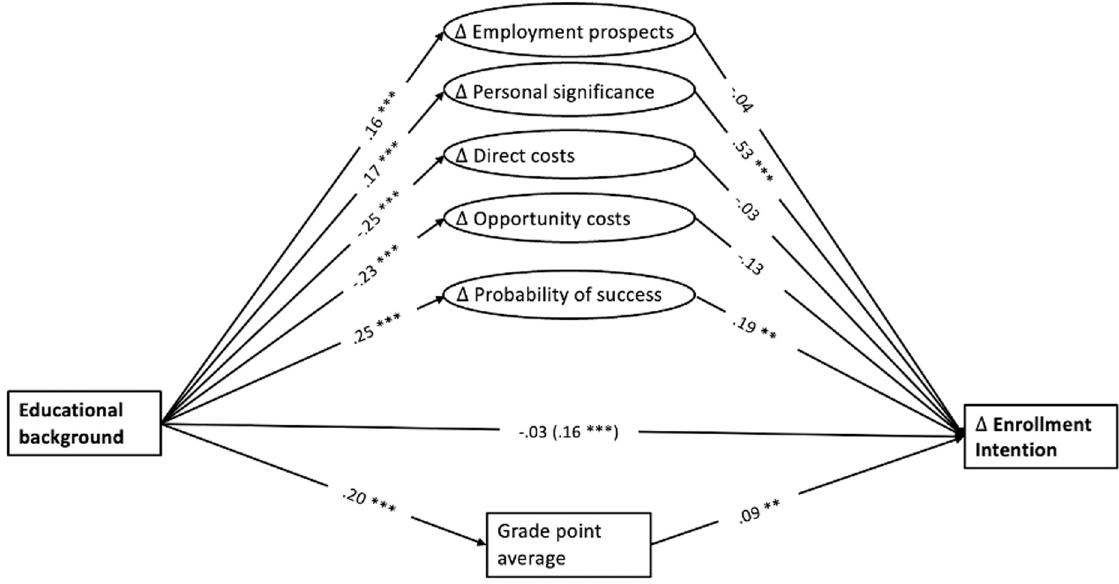
Fig 1. Standardized coefficients of the mediation model of educational background on intention to enter HE through rational choice patterns and academic performance. Standardized linear regression coefficients are presented. The total effect is presented in brackets. Educational background: 0 = non-academic household; 1 = academic household. We controlled for age, gender, grade level, type of school, nationality, and mother tongue. � p < .05. �� p < .01. ��� p < .001.